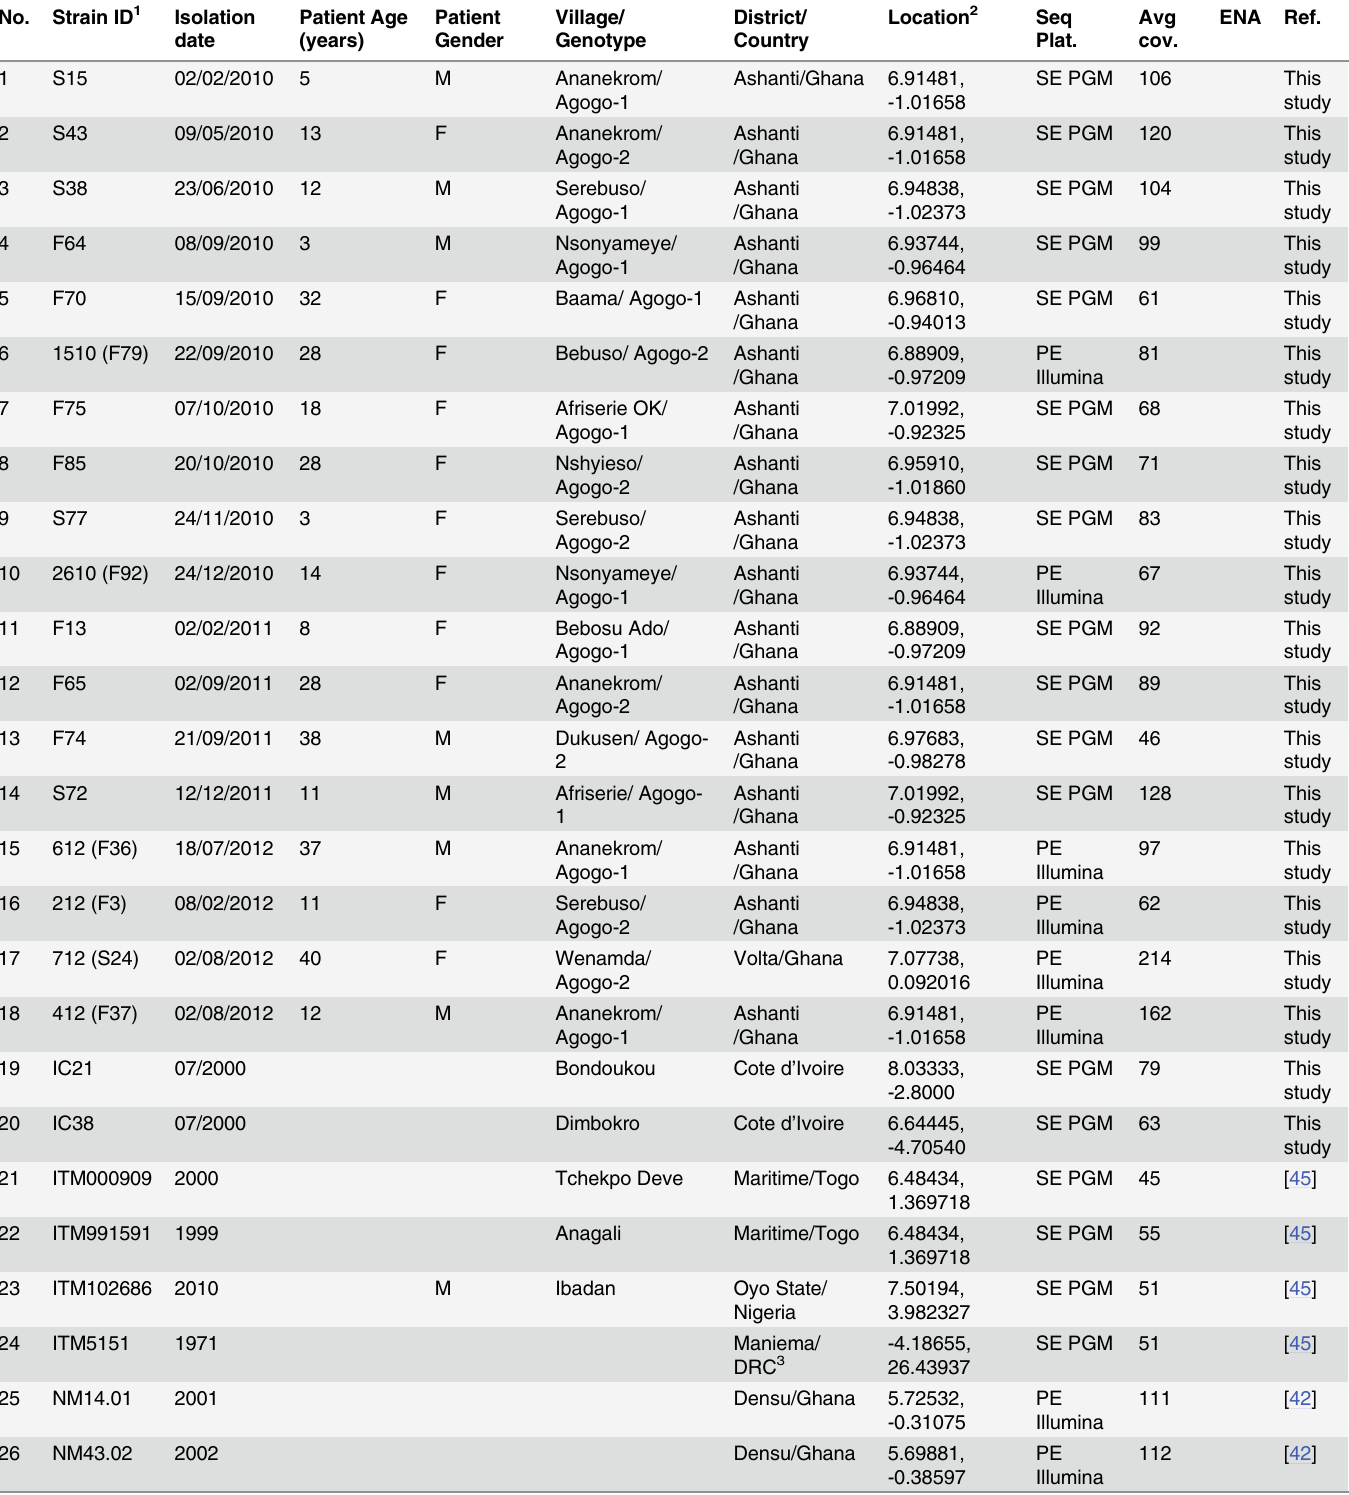
Table 1. M . ulcerans isolate and DNA sequencing